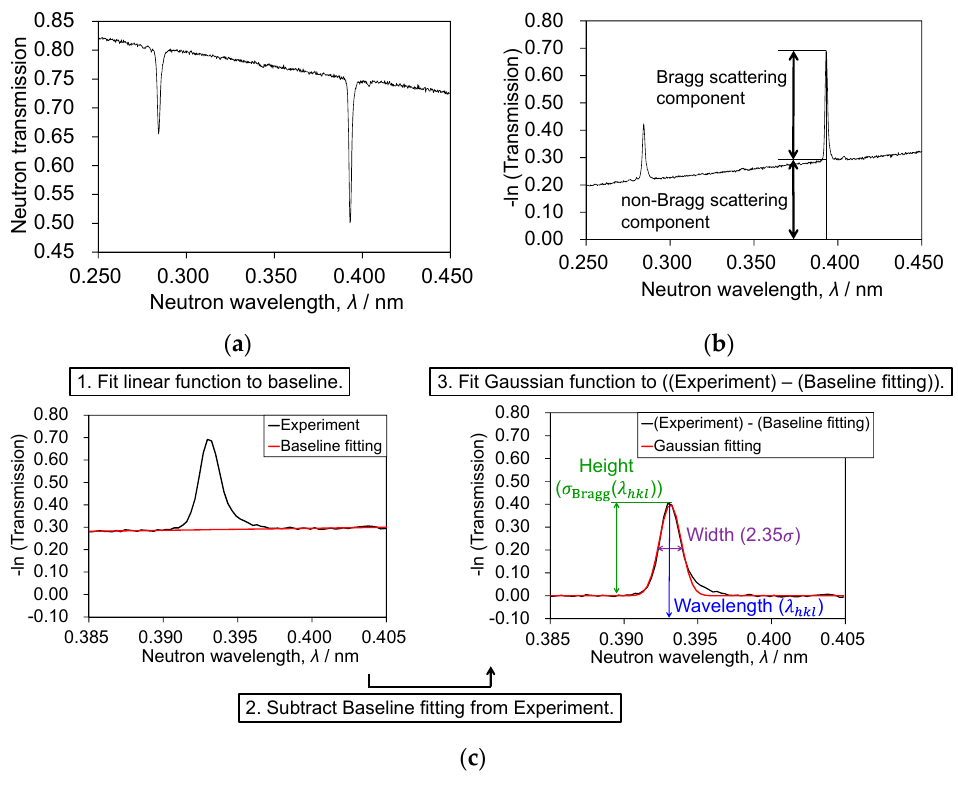
Figure 3. ( a ) The neutron transmission spectrum of Grain 3. ( b ) The negative value of the natural logarithm of transmission. ( c ) The procedure of the profile fitting and the Bragg-dip profile information obtained by the profile fitting.